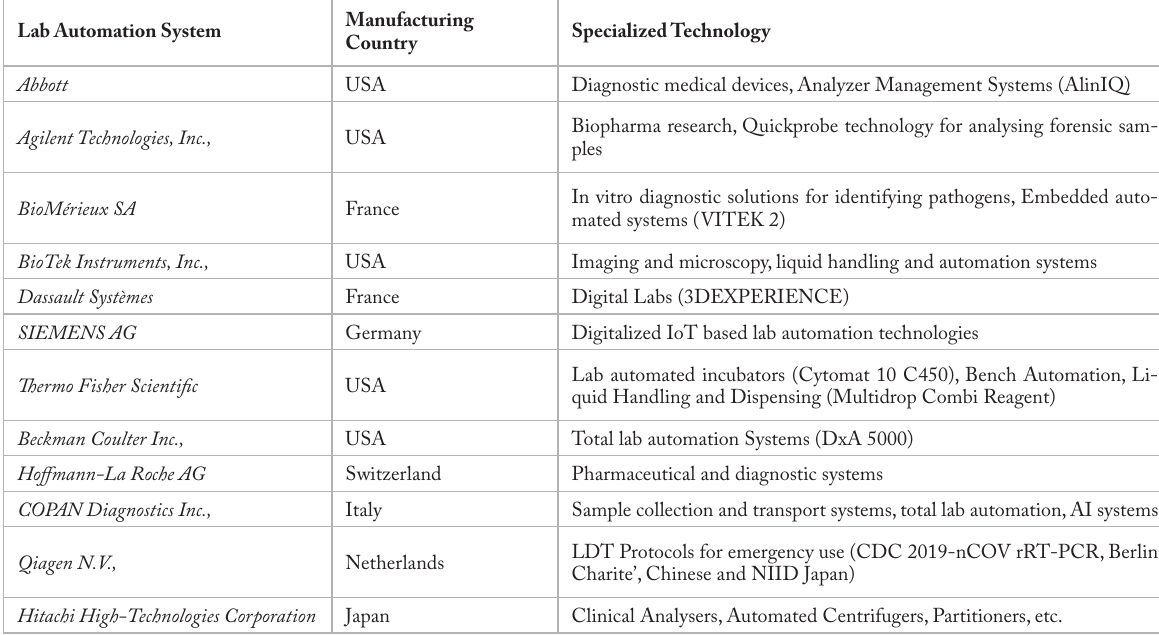
Table 2. Global lab automation systems in the market with significant